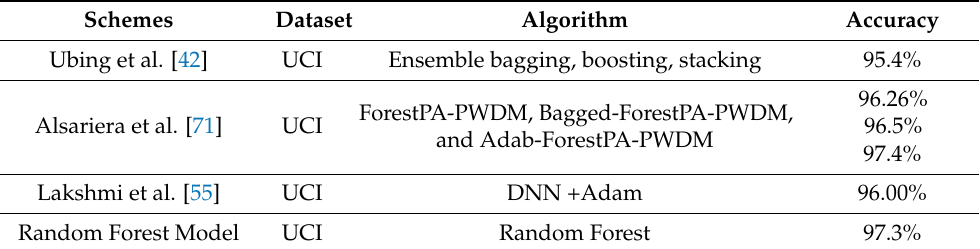
Table 5. Examining existing phishing domain detection